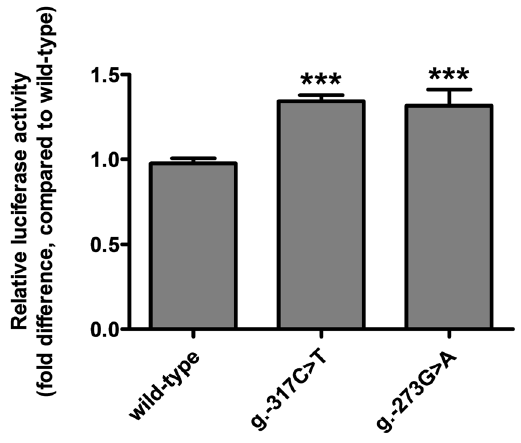
Figure 1. Luciferase activities of the vectors containing SHP-2 promoter variations. The luciferase activities were measured 48 h after transfection of the reporter vectors containing the wild-type SHP-2 promoter sequence or its genetic variations into HCT-116 cells. Then, the luciferase activity of each vector was compared with that of the wild-type. The data (mean ± SD) were obtained from triplicate wells. *** P < 0.001 vs. wild-type.